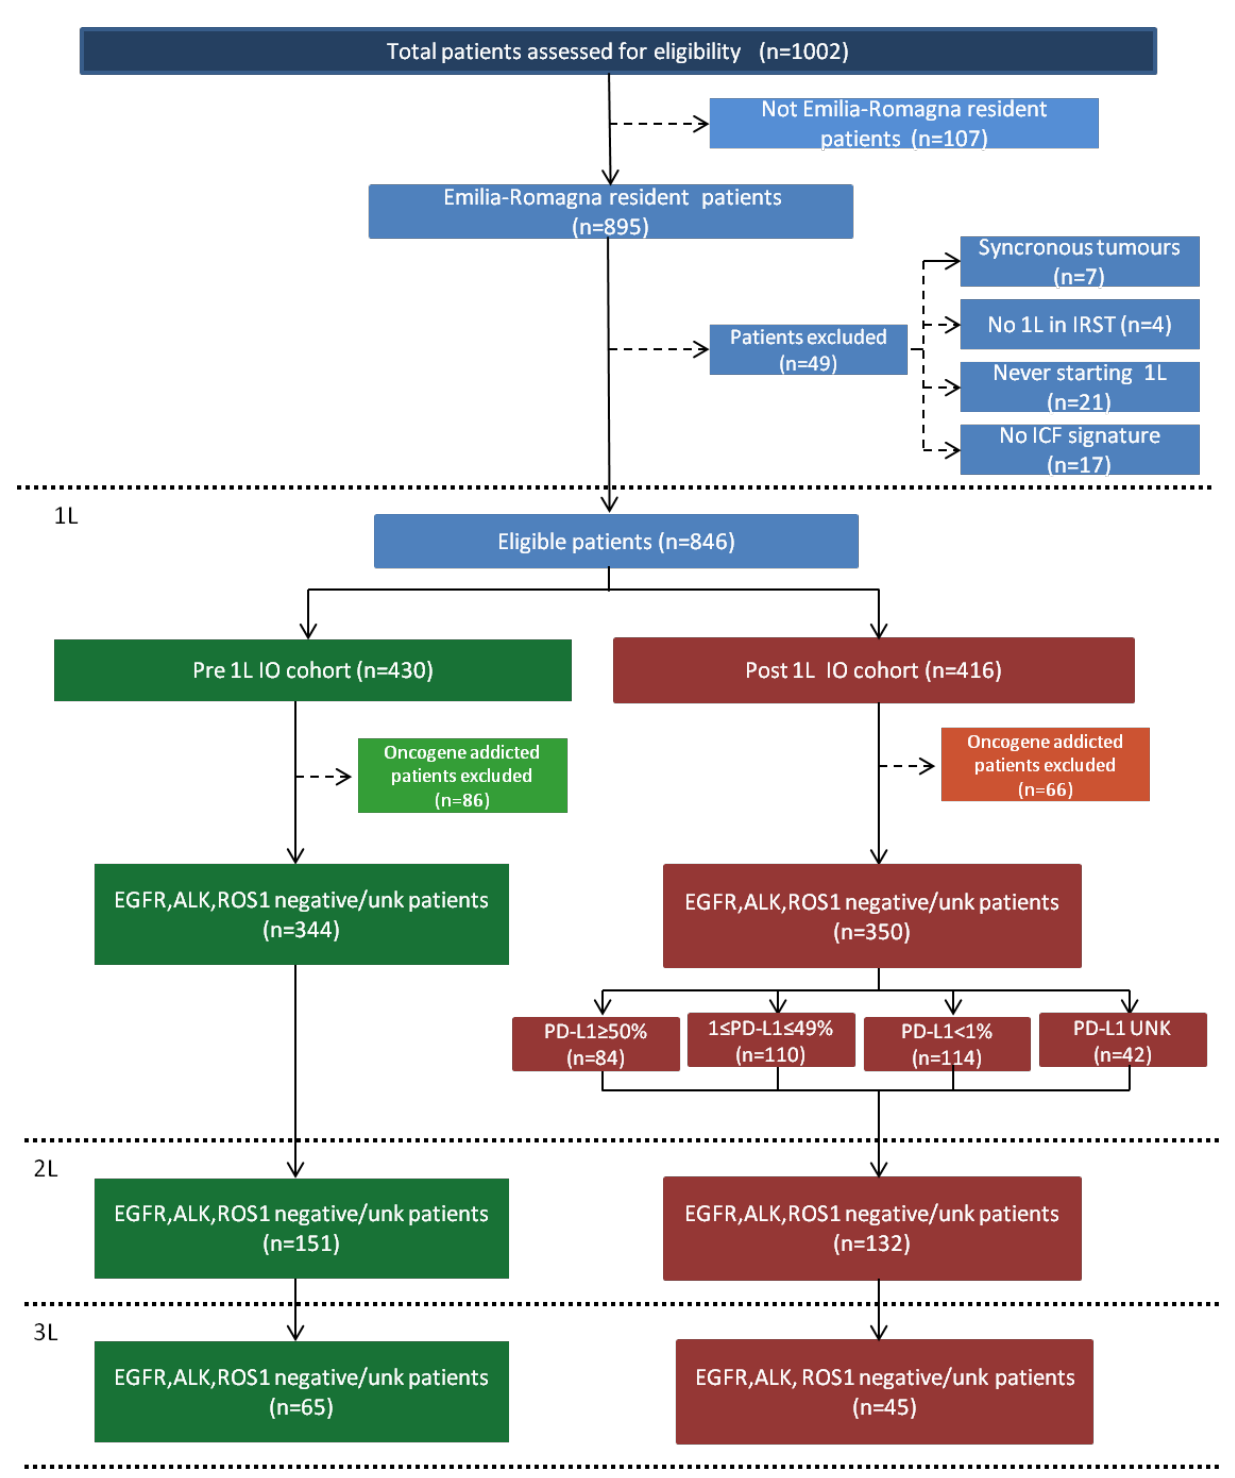
Figure 1. Patient flow chart. A total of 1002 NSCLC patients were assessed for eligibility. We excluded non-residents of the Emilia-Romagna region ( n = 107). Other exclusions were made for patients with synchronous tumours ( n = 7) patients who did not sign ICF ( n = 17), patients who died before starting 1L treatment ( n = 21) or received the 1L treatment in a different site to IRST ( n = 4). Patients who met eligibility criteria ( n = 846) were grouped into Pre- ( n = 430) and Post-1L IO cohort ( n = 416). A total of 86 and 66 patients were further excluded from Pre- and Post-1L IO, respectively, due to the oncogene-addicted tumor. A total of 694 patients were included in this analysis, grouped into Pre- ( n = 344) and Post-1L IO